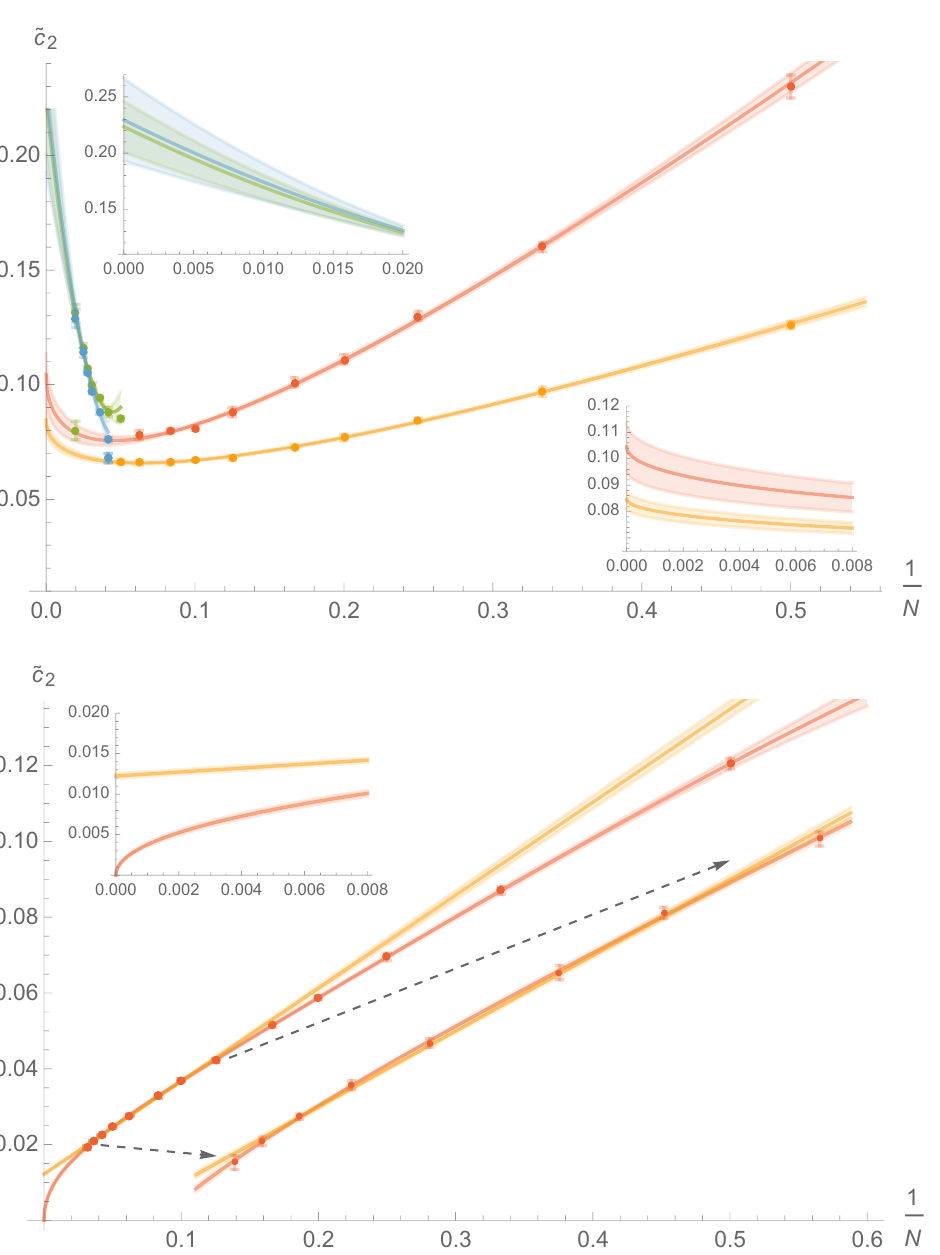
Figure 5 . (top) Transitions for c 4 = 0 . 01 , ν k = 0 , N ≤ 50 with zoomed-in large N limit. Top plots e represent C (red and green) and the bottom ones χ (orange and blue). N < 16 is the 2-phase regime (red and orange) and N > 16 is the 3-phase regime (blue and green). The l→↑↓ transition peak fully separates from ↑↓→↑↑ peak for N ≥ 50 . Pale-coloured stripes represent the 68% confidence intervals. (bottom) Transitions for c 4 = 0 . 01 , ν k = 0 . 5 , N ≤ 32 with two zoomed-in regions. The e orange/top line represents the linear fit for N ≥ 8 , the red/bottom one is our model’s prediction. Pale-coloured stripes represent the 68% confidence